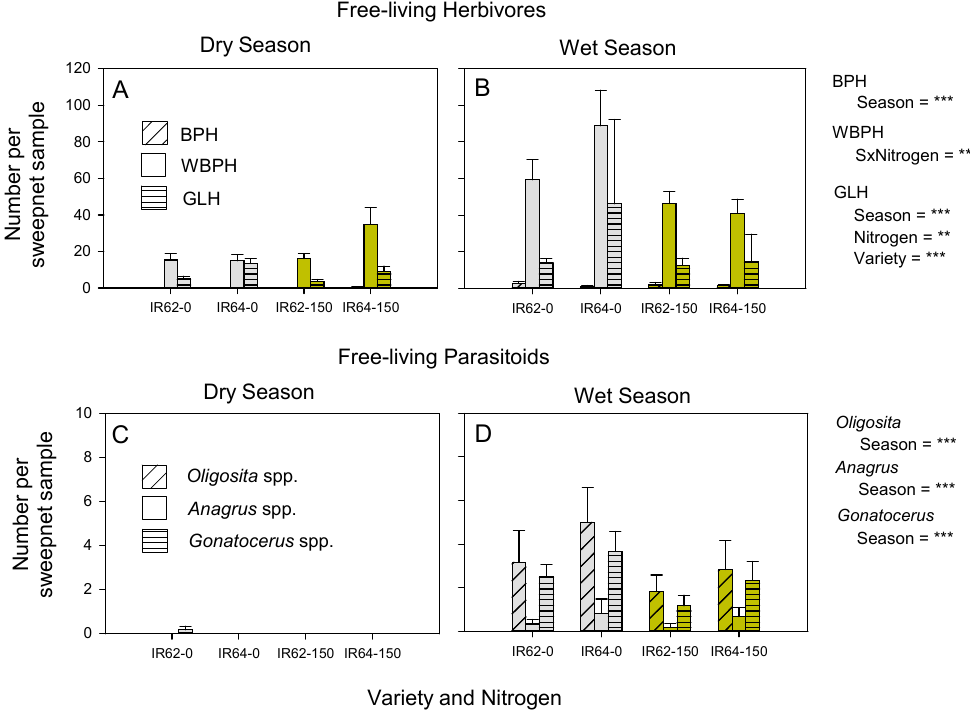
Figure 1. Numbers of planthoppers ( A , B ), leafhoppers ( A , B ) and free ‐ living egg parasitoids ( C , D ) collected at plots of resistant (IR62) and susceptible (IR64) rice under low (gray bars: 0 added) and high (yellow bars: 150 Kg N ha − 1 ) levels of nitrogenous fertilizer. Sampling was conducted using sweep nets during the 2013 dry ( A , C ) and wet ( B , D ) seasons. Standard errors are indicated (N = 6); note differences in scales; results of GLM are indicated as ** = p ≤ 0.05 and *** = p ≤ 0.001; BPH = brown planthopper, WBPH = whitebacked planthopper, and GLH = green leafhopper; S = season. Egg parasitoids were also more abundant during wet season sampling ( Oligosita spp.: